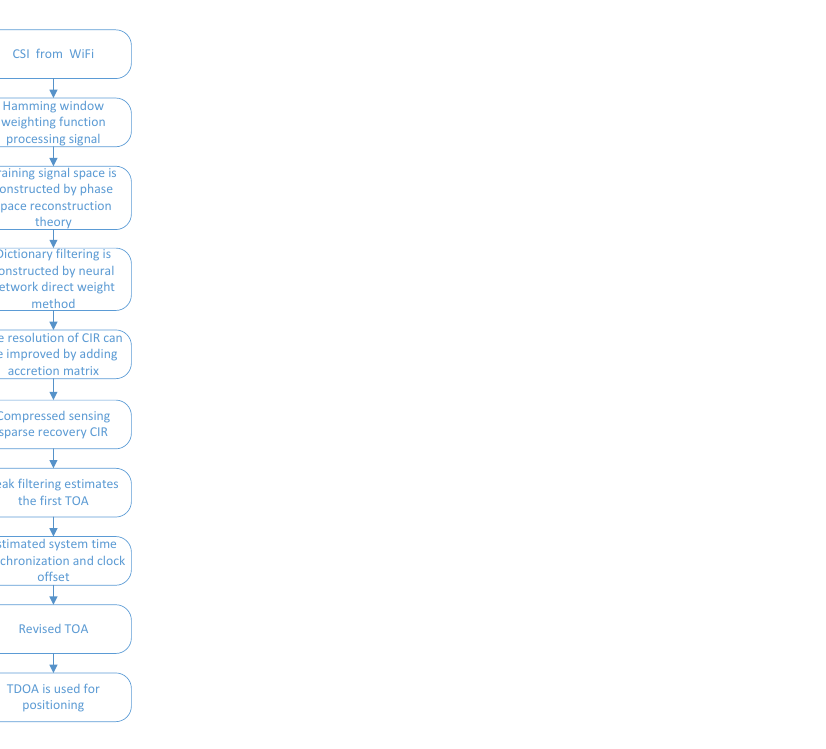
Figure 3. Algorithm framework is based on CSI